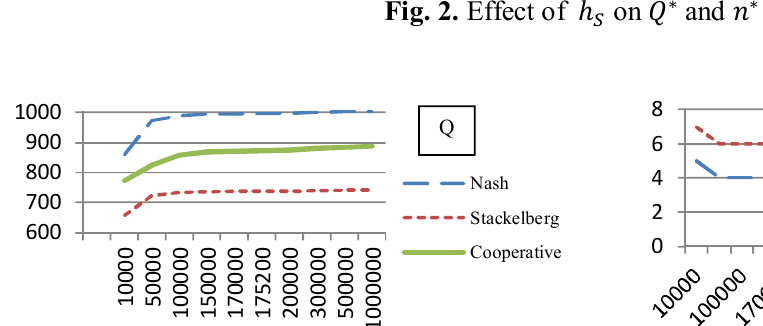
Fig. 2. Effect of ℎ